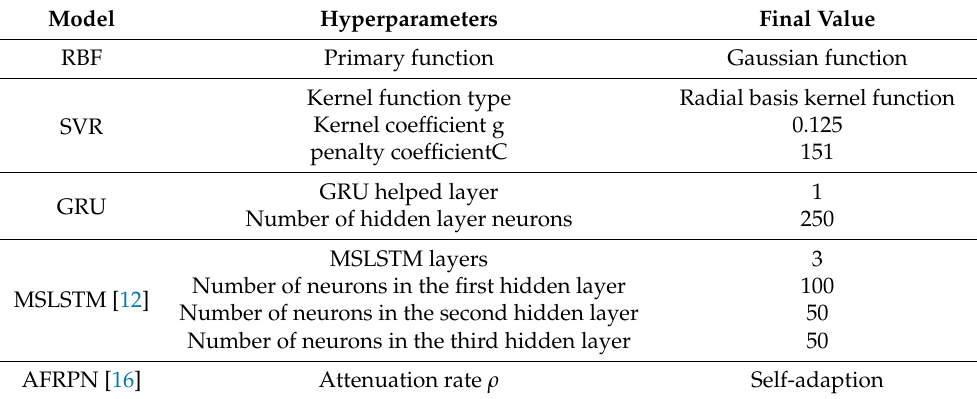
Table 9. Hyperparameters of different prediction models.